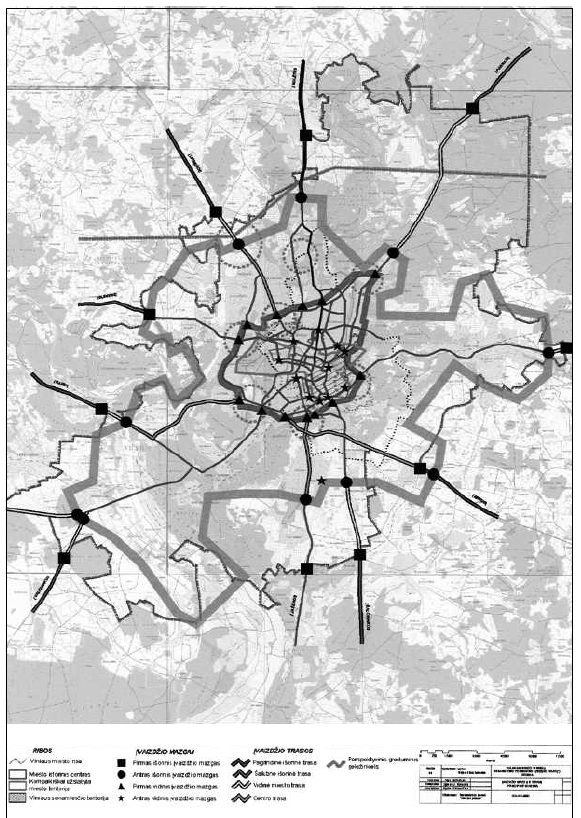
Fig 12. Scheme of Vilnius city urban-architectural image. Vilnius city Strategic Plan for 2002–2011 („Vilniaus planas“,